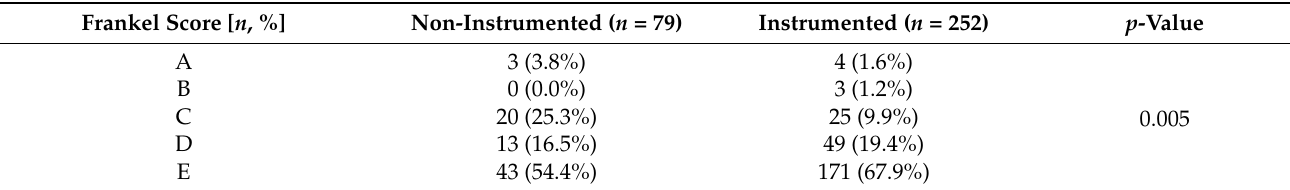
Table A2. Frankel score at initial examination.